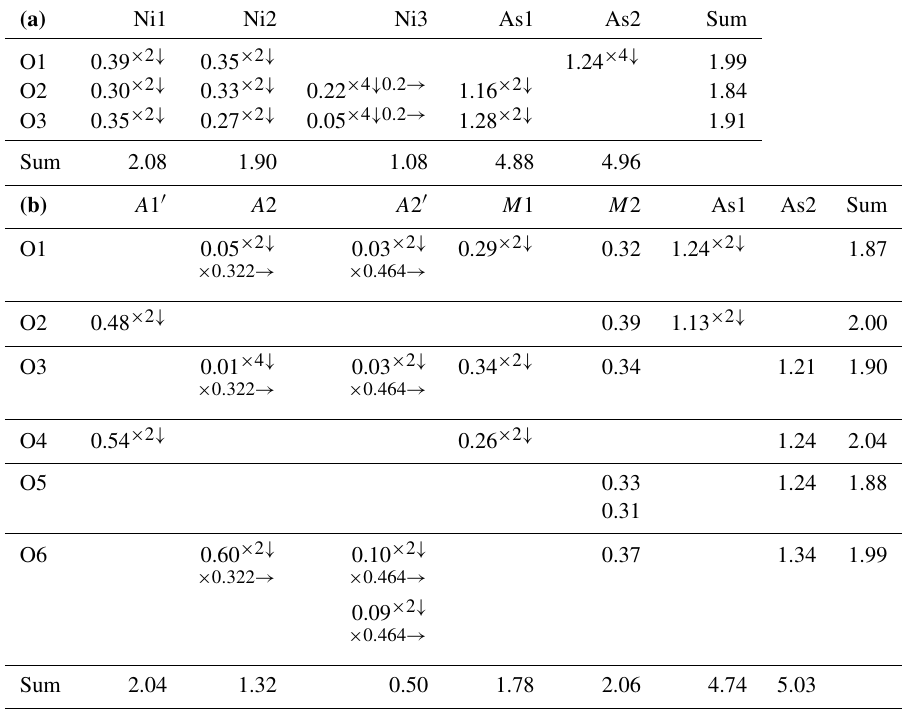
Table 6. (a) Bond-valence analysis for niasite. Values are expressed in valence units (vu). (b) Bond-valence analysis for johanngeorgen- stadtite. Values are expressed in valence units (vu).